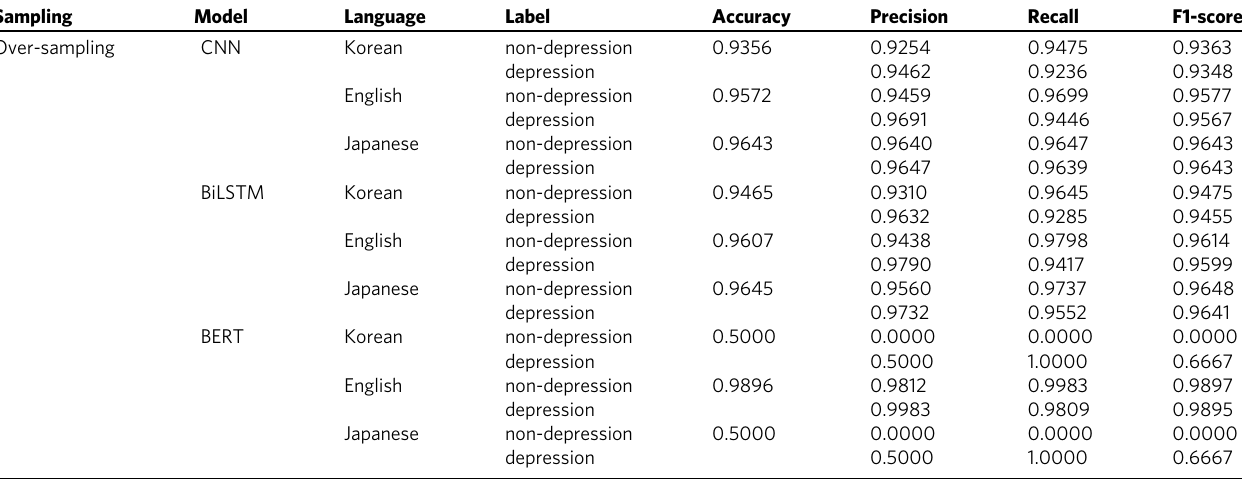
Table 5 Results of the binary classi fi cation task on Twitter with over-sampling.